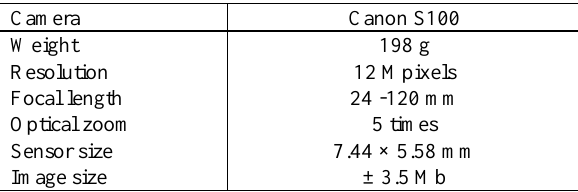
Table 1. Camera specification